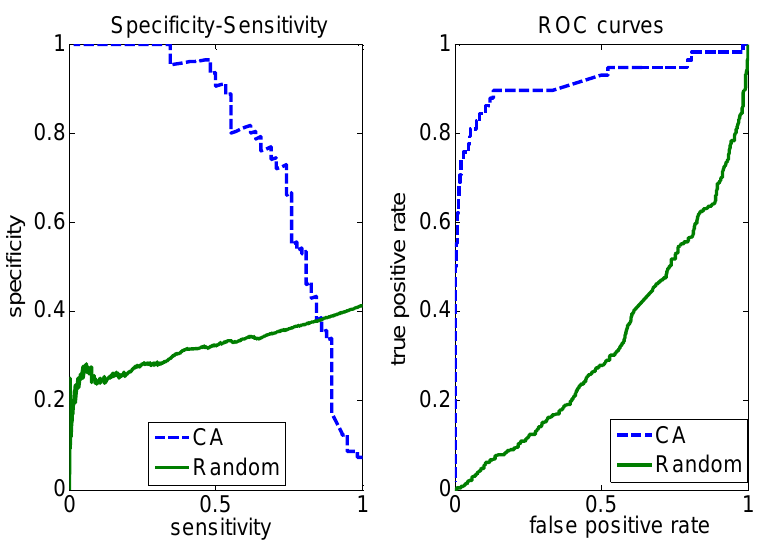
Figure 1. Specificity-sensitivity and ROC curves on the Complete dataset.